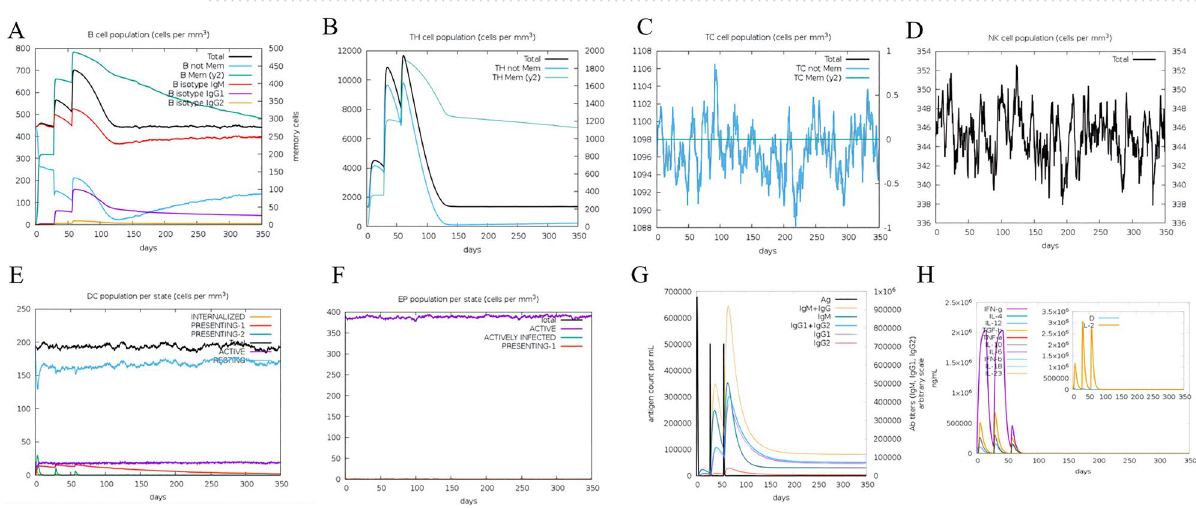
Figure 10. ( A ) The B-cell isotypes in various states. ( B ) The Th-cell isotypes in various states. ( C ) The TC-cell isotypes in various states. ( D ) The NK-cell in various states. ( E ) The DC-cell in various states. ( F ) The EP in various states. ( G ) The immunoglobulin in various states. ( H ) The interleukins and cytokines are in various